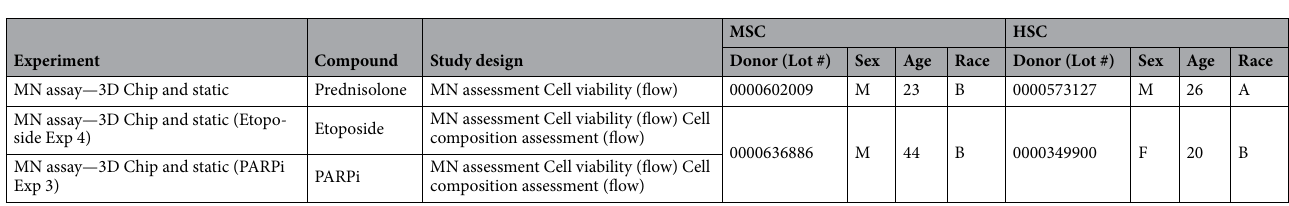
Table 2. Cell donor information. F female, M male, A Asian, B